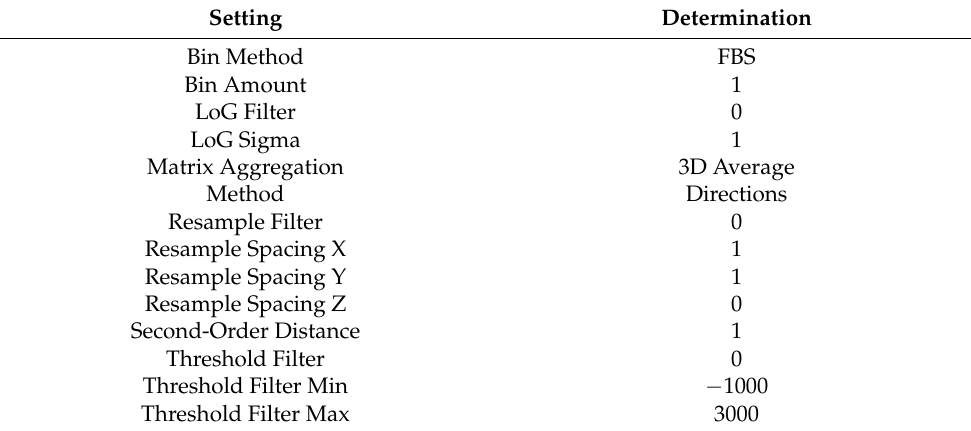
Table A1. Settings of the feature extraction.